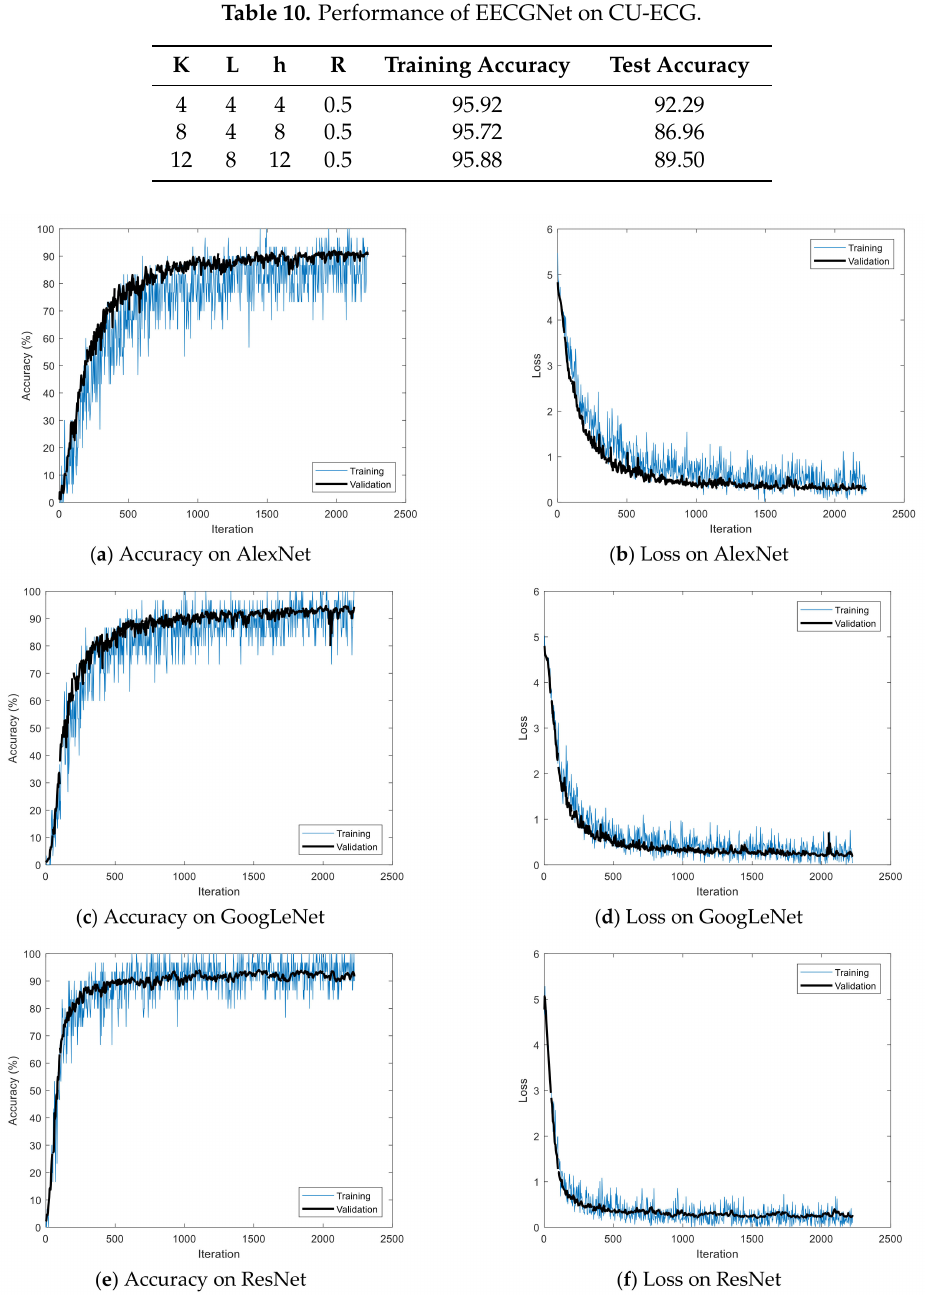
Figure 14. Training processes in